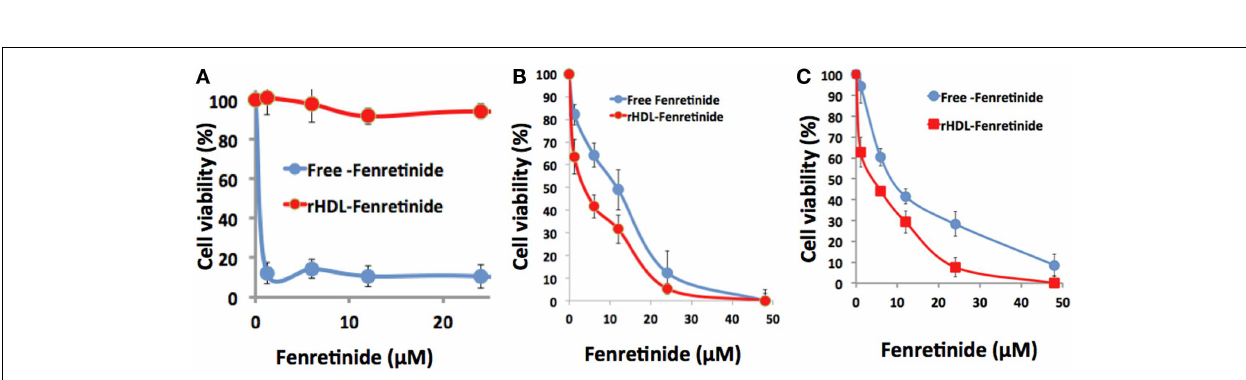
(BLT), a known inhibitor of SR-B1 receptor. At 0.4 µ M BLT,